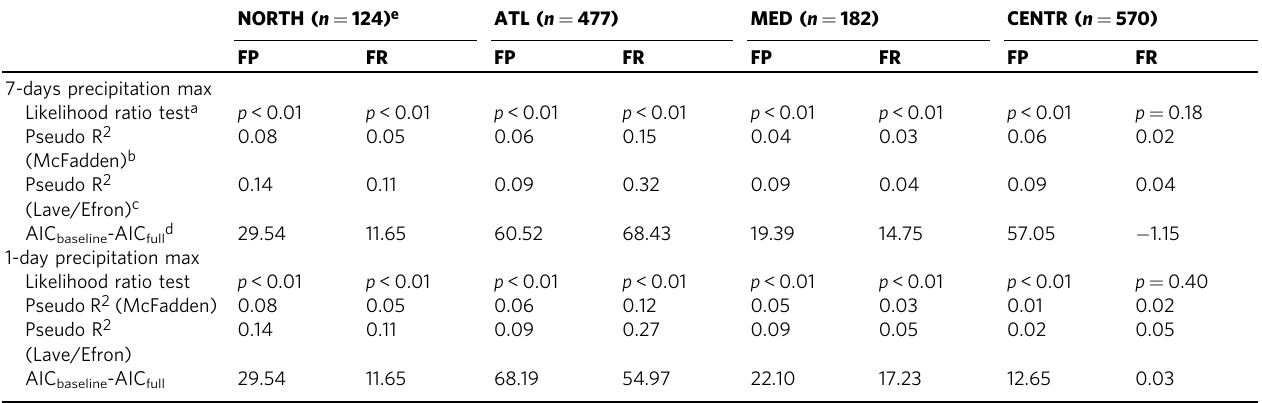
Table 1 Performance of binomial generalised linear models predicting the probability of occurrence of fl ood anomalies in each region using portions of fl ood generation processes and different precipitation indices as explanatory